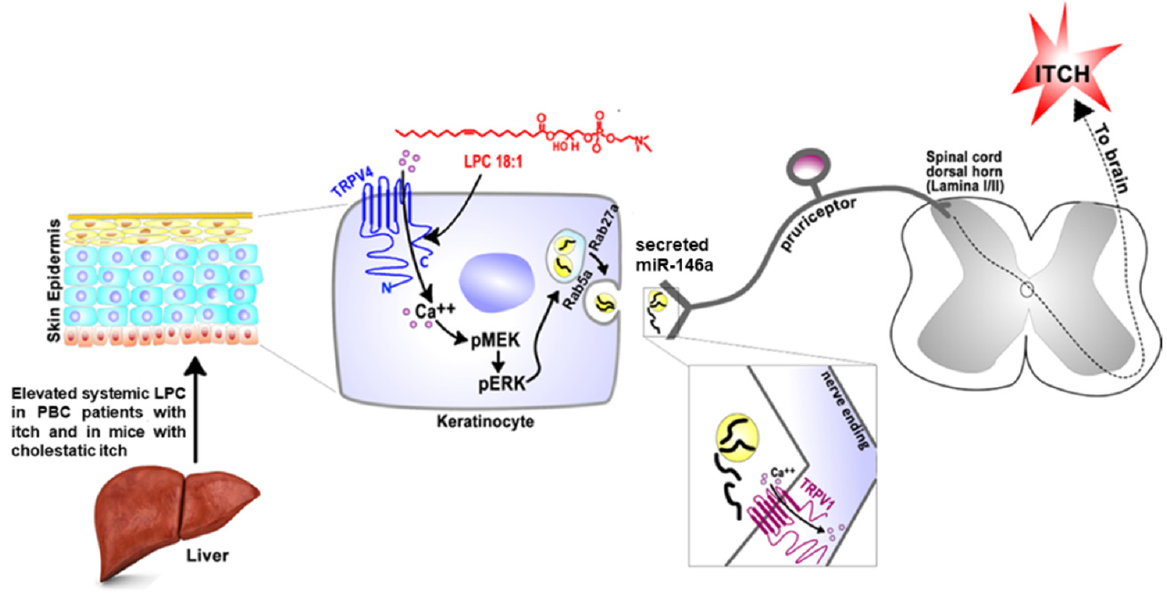
Figure 1. Schematic diagram depicting the potential mechanism underlying cholestatic itch. Cholestatic liver disease is associated with significantly elevated systemic LPC, which directly activates TRPV4 expressed in skin keratinocytes. This in turn leads to extracellular release of miR-146a via MEK–ERK–Rab5a/Rab27a signaling pathways. miR-146a functions as a pruritogen by activating TRPV1-expressing pruriceptor sensory neurons that innervate the skin. Activation of TRPV1 by miR-146a induces the sensation of itch via central pathways.